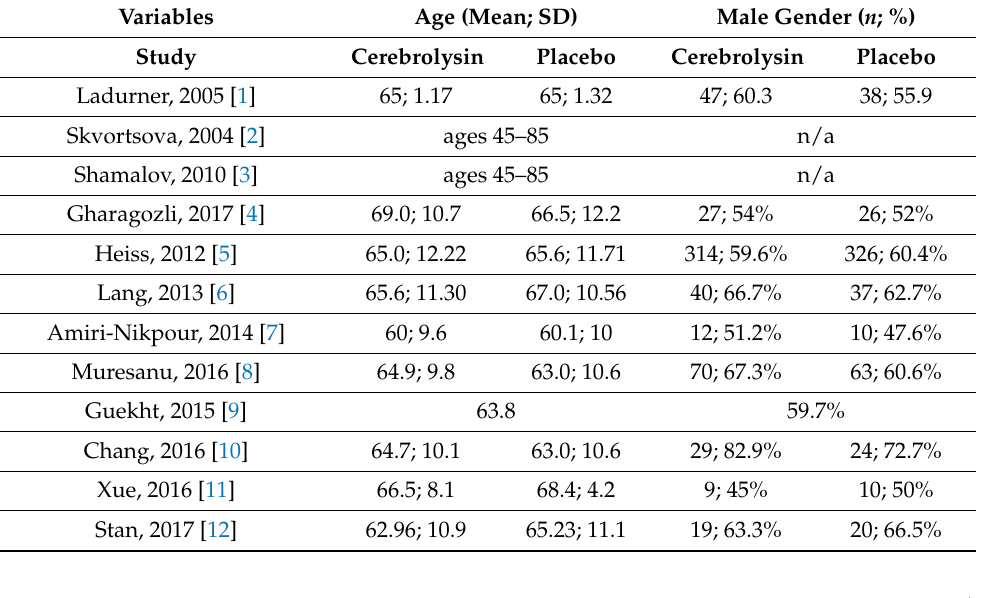
Table 2. Demographic characteristics of studies included in the analysis.